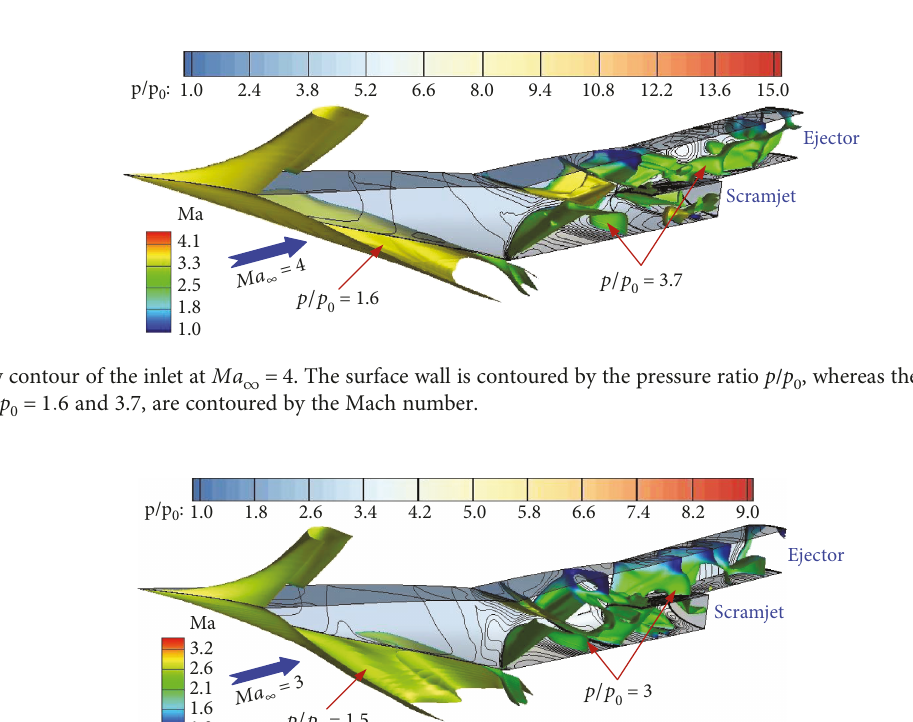
Figure 6: Flow contour of the inlet at Ma respectively, p / p 0 = 1 8 , 4.5, and 12.5, are contoured by the Mach number.